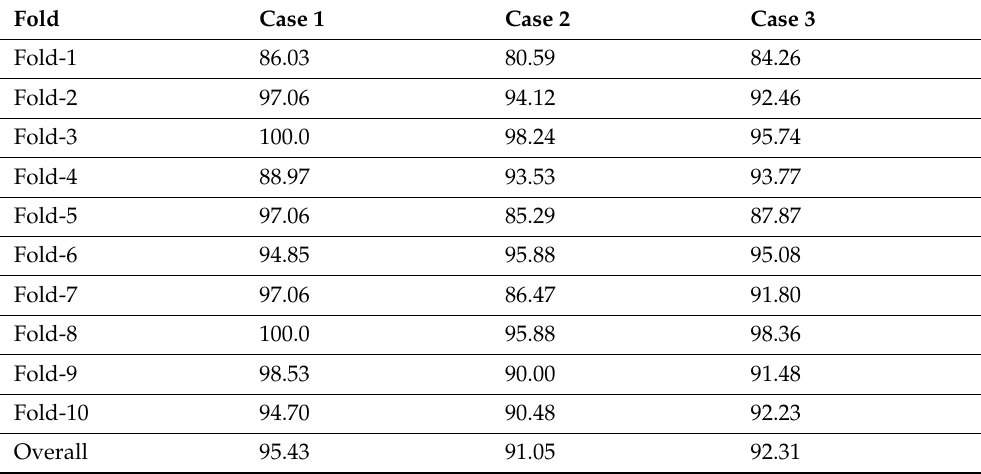
Table 5. Fold-by-fold accuracies in % for the three